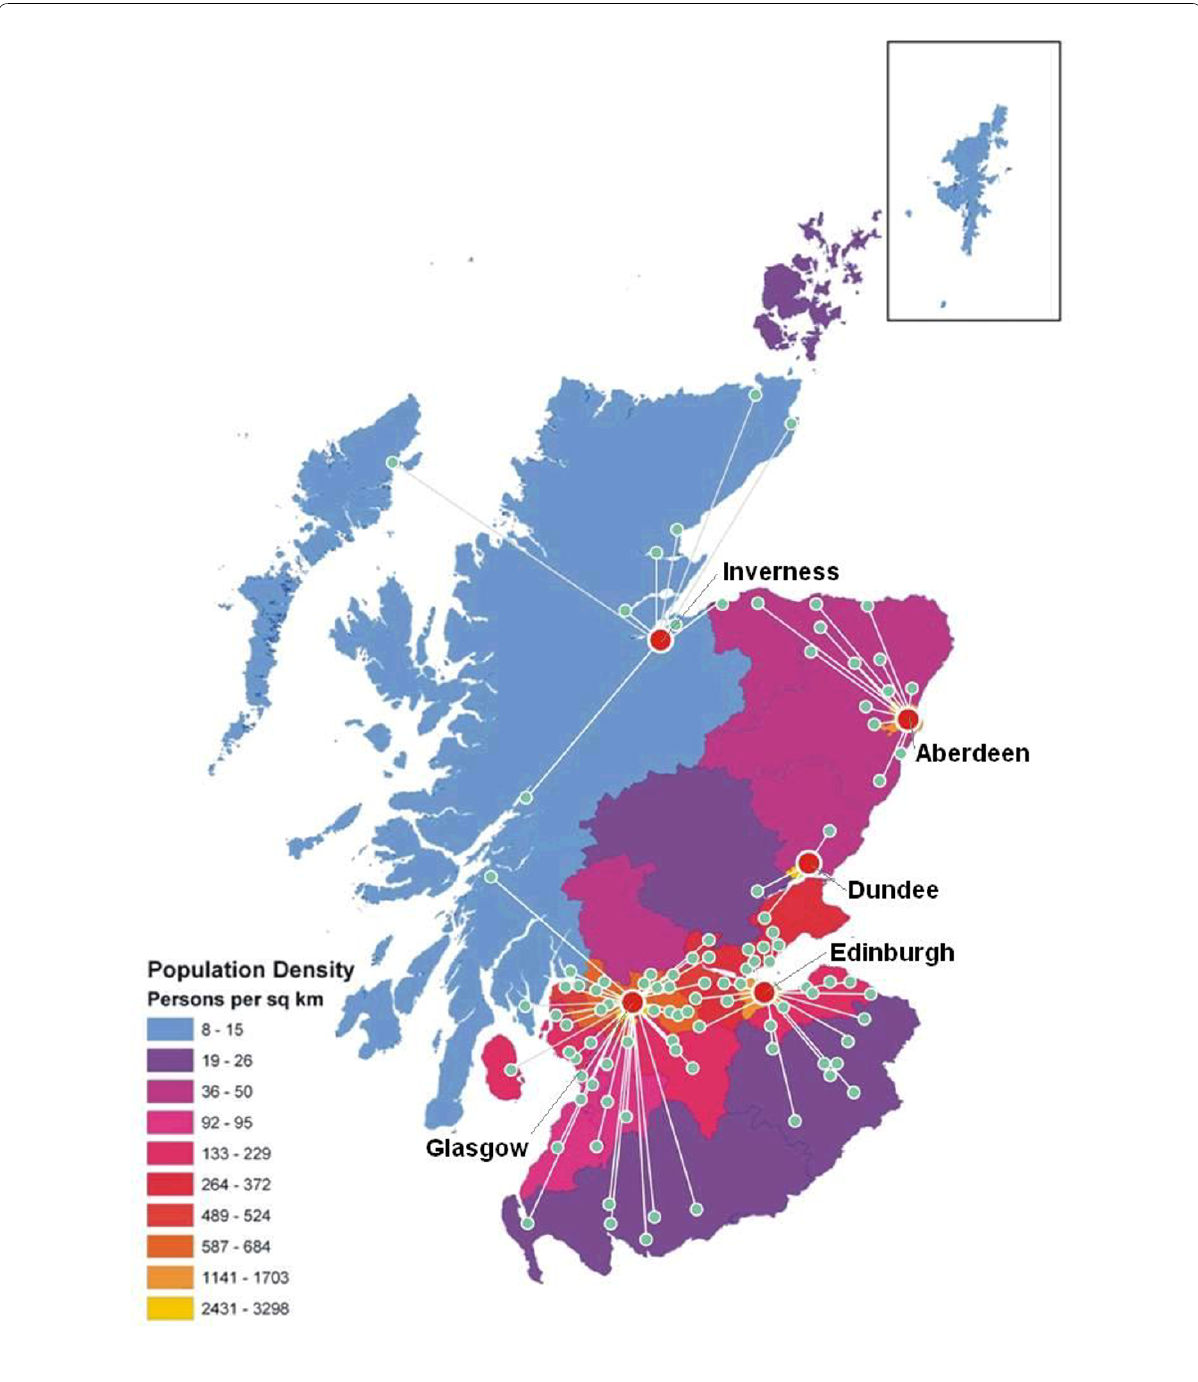
Figure 2 GS:3D Locations . Map of Scotland showing locations in which participants were recruited to GS:3D. SNBTS Donor Centres in Inverness, Aberdeen, Dundee, Edinburgh and Glasgow are indicated by large circles and clinics under the management of each centre are indicated by smaller circles with connecting